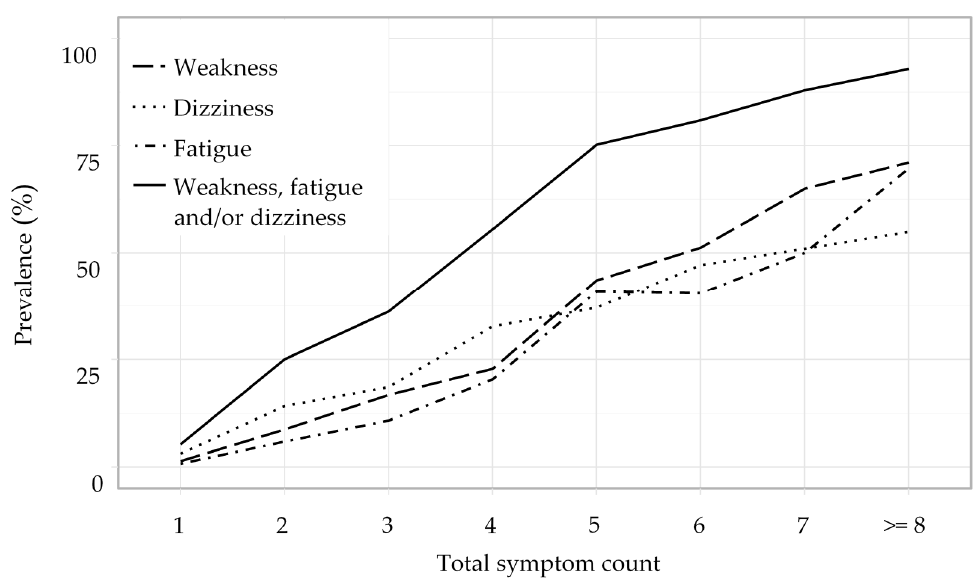
Figure 1. Prevalence of nonspecific complaints (NSCs) in relation to the total symptom count.